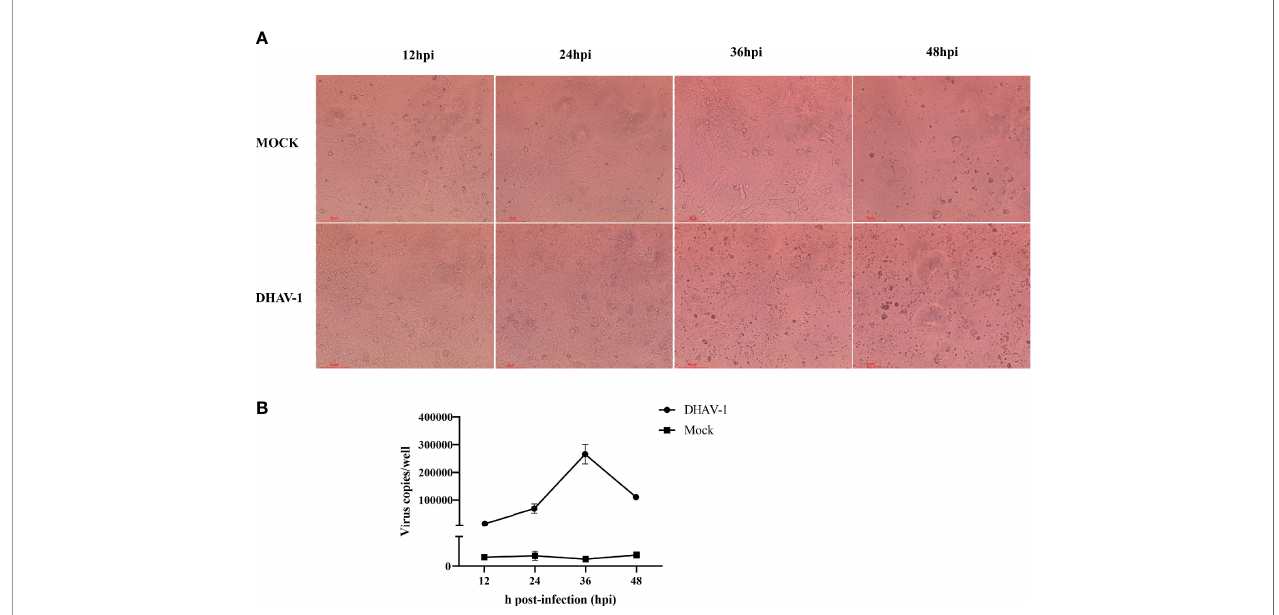
FIGURE 1 | Characteristics of DEFs following DHAV-1 infection at 12, 24, 36, and 48 hpi. (A) . Represent morphology of mock-infected and DHAV-1-infected DEFs at 12, 24, 36, and 48 hpi. (B) . The viral copy numbers of DHAV-1 on DEF cells with an MOI of 3 at 12, 24, 36, and 48